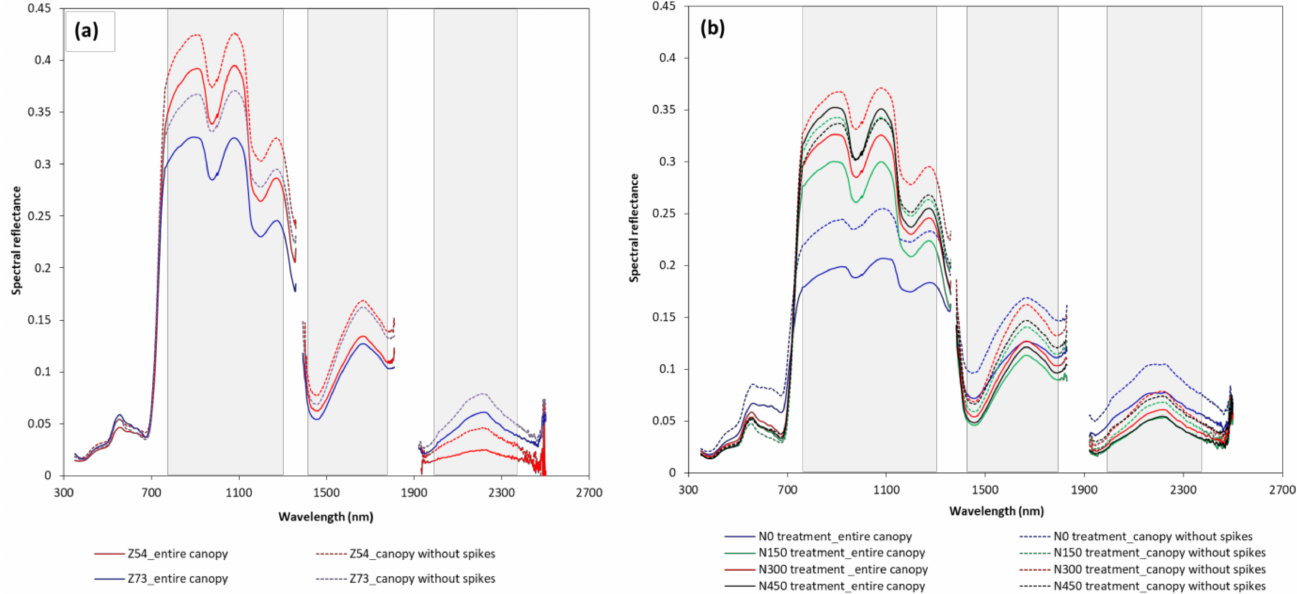
Figure 4. Spectral reflectance of the entire wheat canopy and the canopy without spikes ( a ) at different growth stages under the N300 treatment, and ( b ) under different N treatments at the milk-filling stage